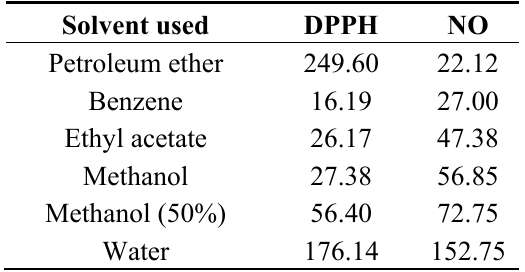
= μ g/mL) of leaves 50